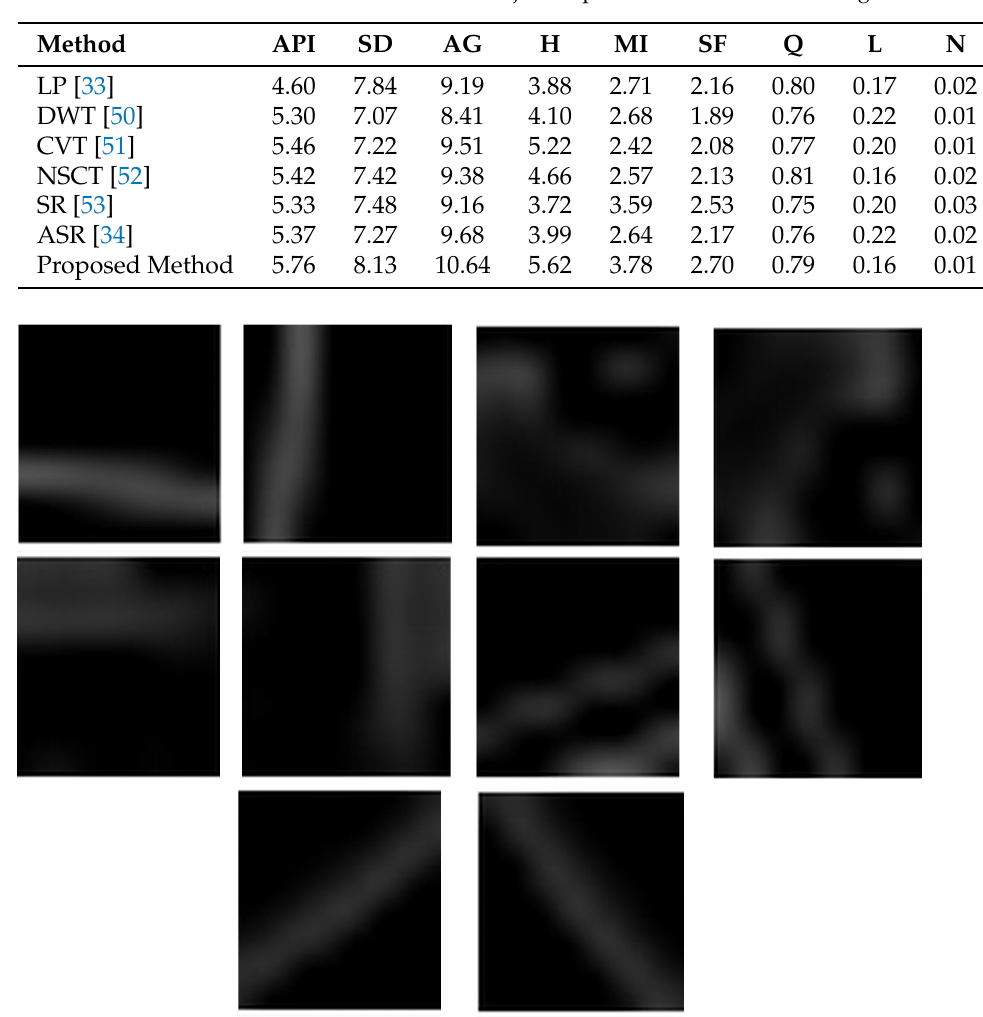
Table 3. Conventional statistical indicators and objective performance measures of Figure 12.